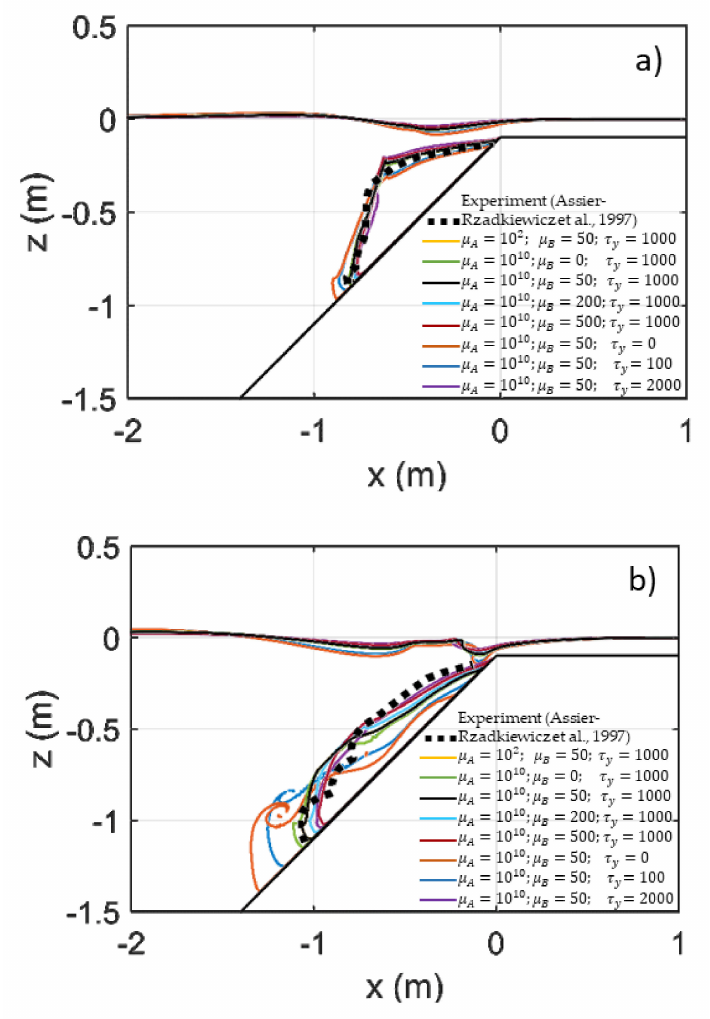
Figure 9. The comparison of the free-surfaces and the slump surface profiles of 8 cases with the combinations of un-yield viscosity µ A , yield viscosity µ B , and yield stress τ y at: ( a ) t = 0.4 s and ( b ) t = 0.8